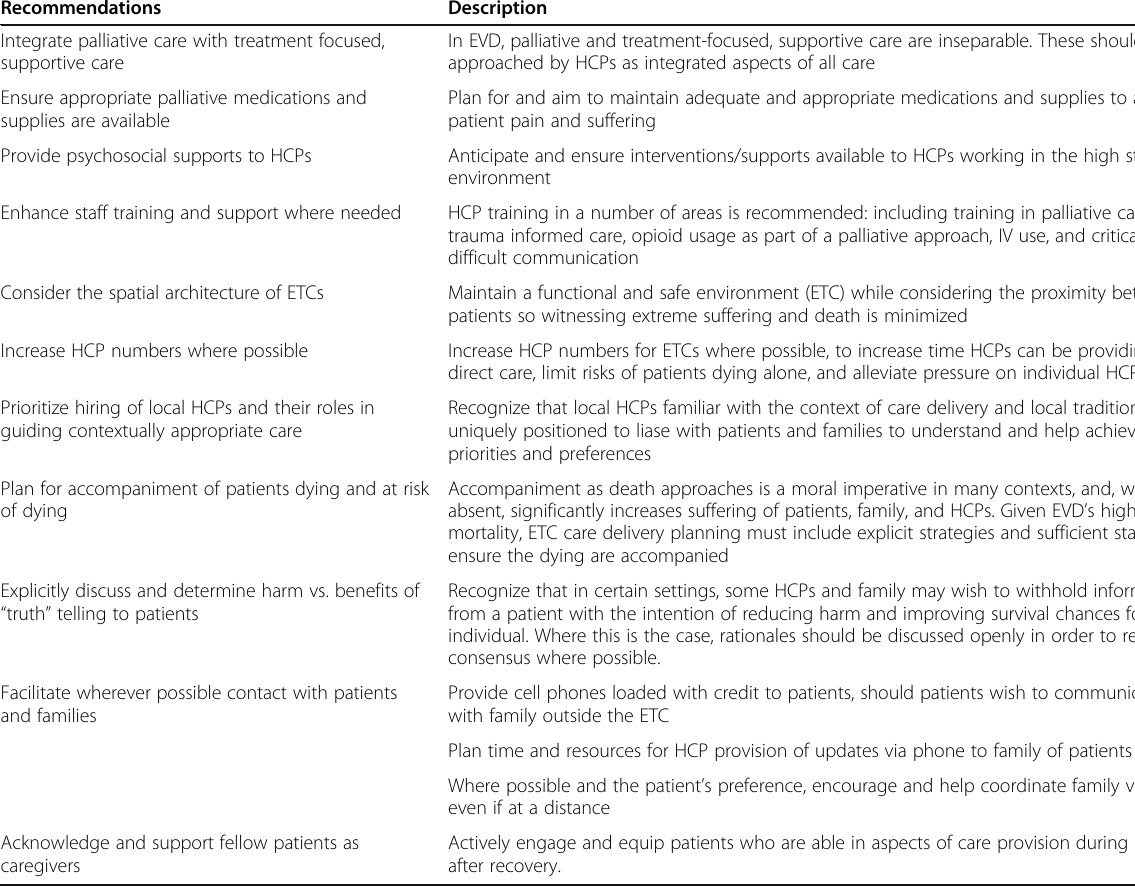
Table 3 Recommendations drawn from findings